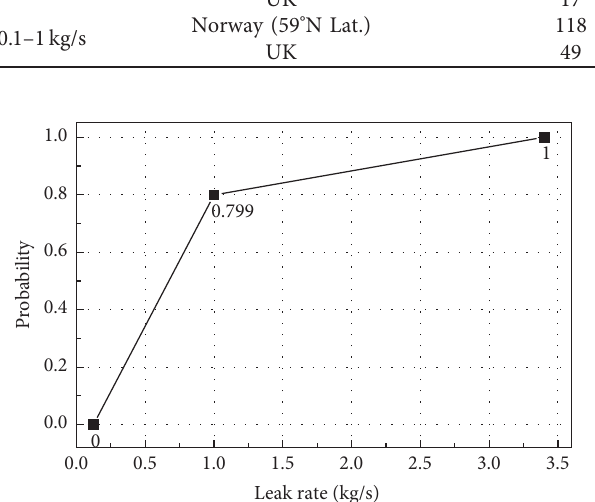
Figure 15: Leak rate cumulative distribution function from in- stallations in the North Sea.